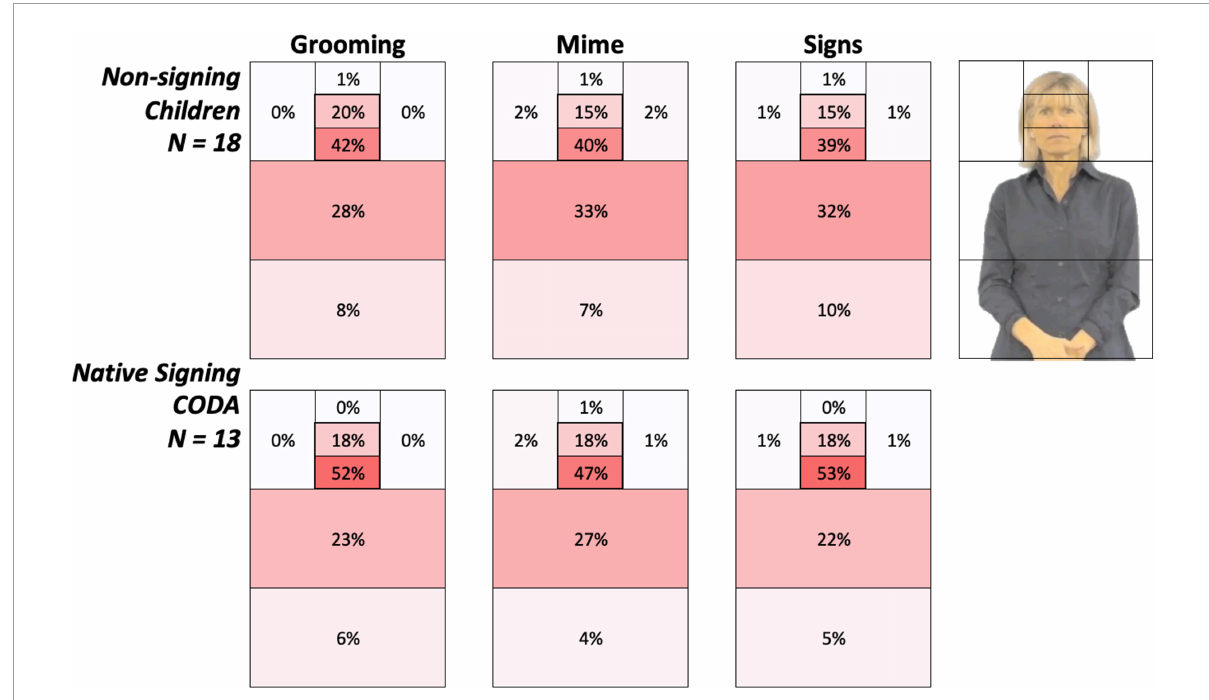
FIGURE4 Heat grids for each language group and body action type conditions. These results show the average percent looking time for each AOI for non-signing ( top ) and native signing children ( bottom ). Color scaling per cell refers to a gradient from the highest (red) to the lowest (white) percent looking values. The most notable overall difference between groups was the greater attention to the face in native signing children, especially for signs, than the non-signing children. Conversely, this also reflects non-signing children’s higher percentage looking at the articulatory